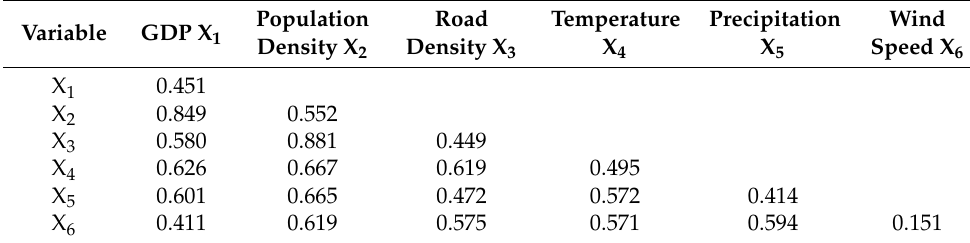
Table 6. Interaction detector results for 2016.